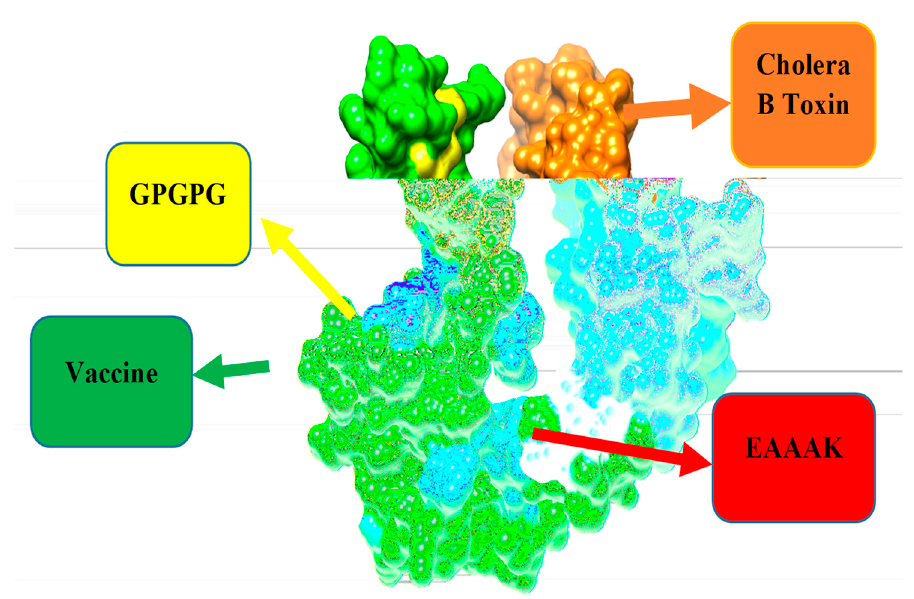
Figure 5. 3D structure of chimeric multi-epitopes vaccine construct.